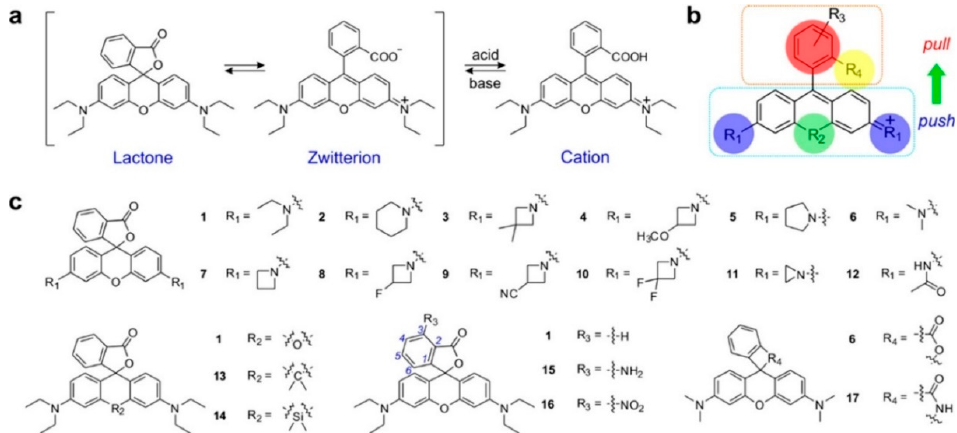
Figure 32. Development of a unified push-pull model: ( a ) Lactone − zwi tt erion − cation equilibrium of rhodamine B; ( b ) Four representative substitution sites of rhodamine derivatives that affect lactone-zwitterion-cation equilibrium; ( c ) Molecular structures of representative rhodamine dyes 1 − 17 used for the calculations. Adapted with permission from [286]. Copyright (2020) American Chemical Society.